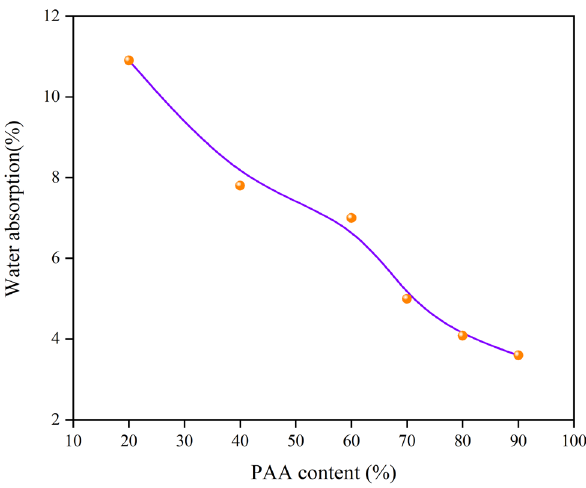
Figure 6: Water absorption of EP/PAA after curing.